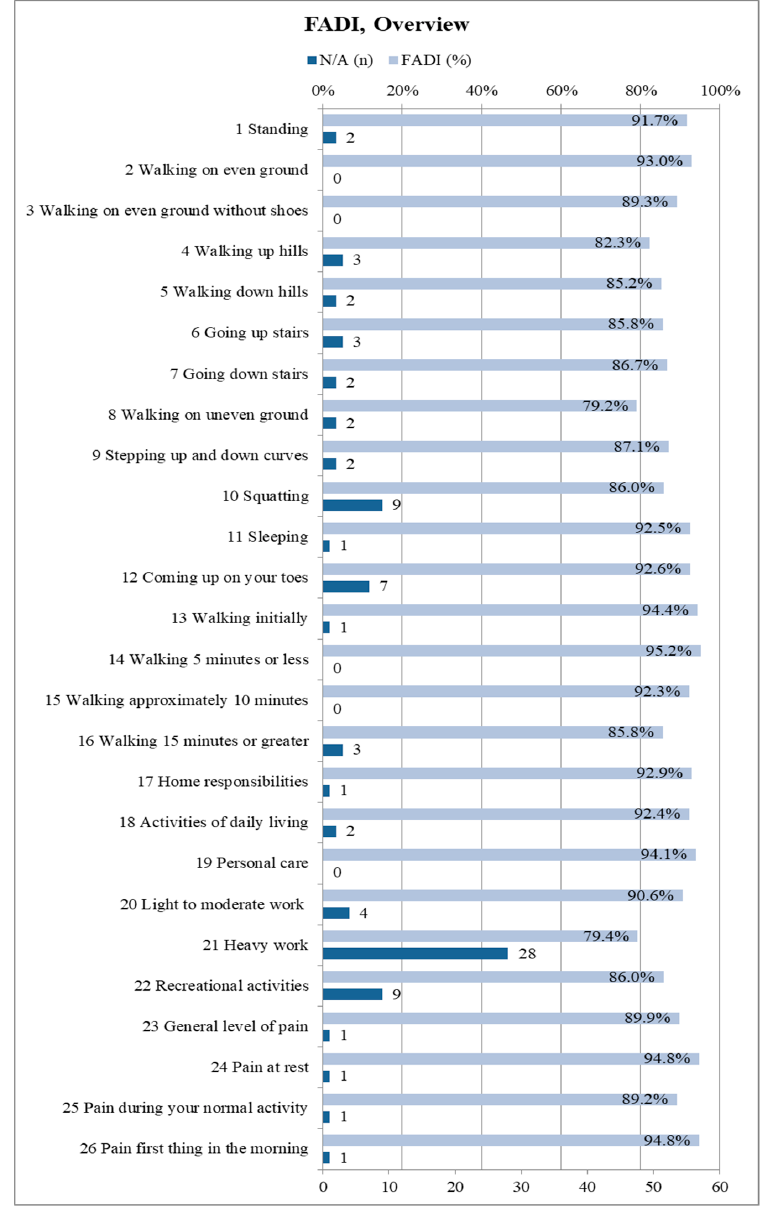
Figure 7. Summary of the Foot and Ankle Disability Index (FADI) results in detail for all 26 items ( n = 68); depicted percentages are mean values; the maximum score of 100% corresponds to 4 points and represents “no difficulty/pain”, 75% corresponds to three points and represents “slight difficulty/mild pain”, 50% corresponds to two points and represents “moderate difficulty/pain”, 25% corresponds to one point and represents “extreme difficulty/severe pain”, 0% corresponds to one point and represents “unable to do/unbearable”; if subjects were limited by something else than their lower leg condition resulting from fibula flap harvest the related item is marked as “N/A” and excluded from the total score.